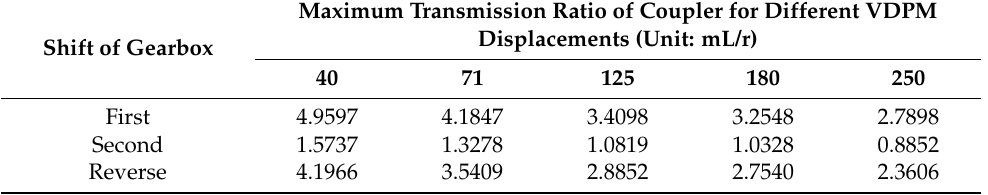
Table 4. Maximum transmission ratio of the coupler for different VDPM.